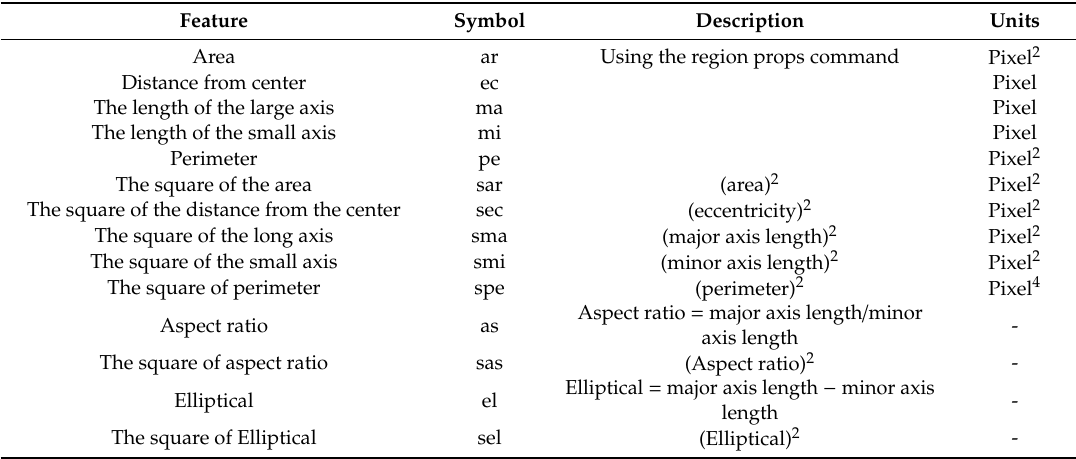
Table 2. Extracted morphological specificities for each rice